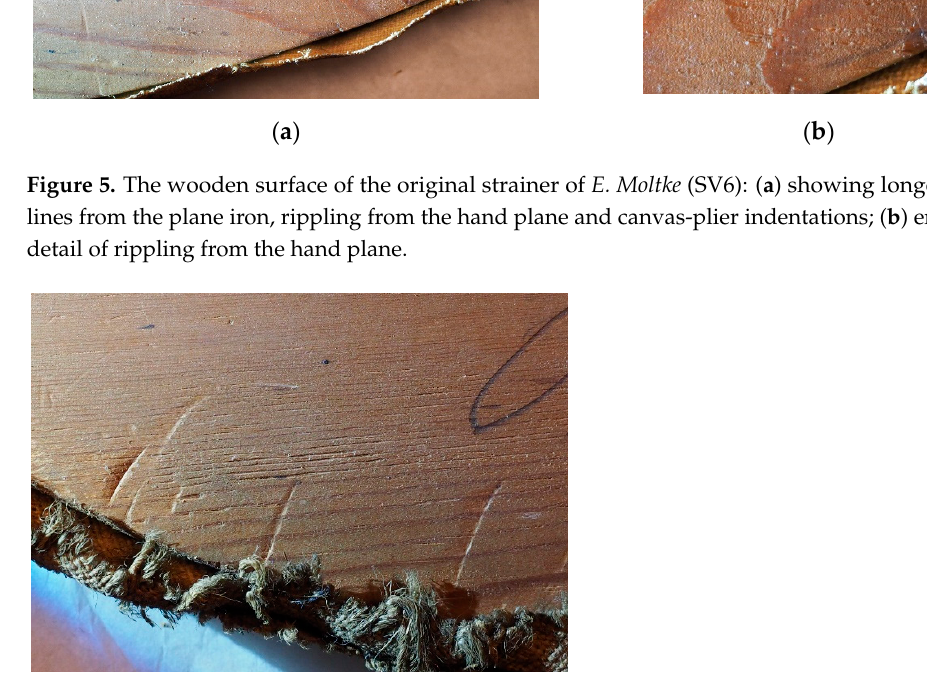
Figure 6. The wooden surface of the original strainer of M.C. Buchwaldt (SV3) showing deep indenta- tions running parallel to the wood grain likely from a toothing plane. Indentations from the use of stretching pliers are visible along the edge adjacent to each